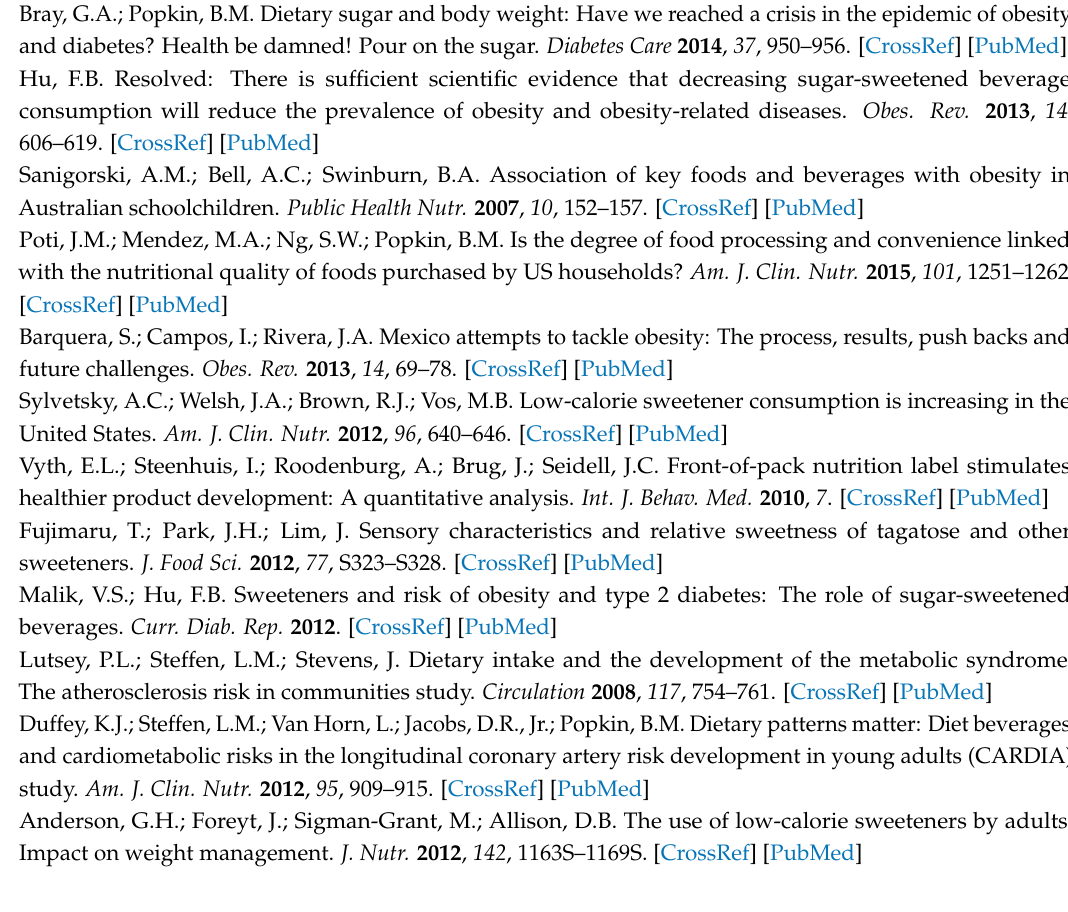
Table S1: Detailed description of data collection for each country, Table S2: Food categorization system, Table S3: List of search terms used in analysis, Table S4: Percentage of products containing added sugar ingredients by